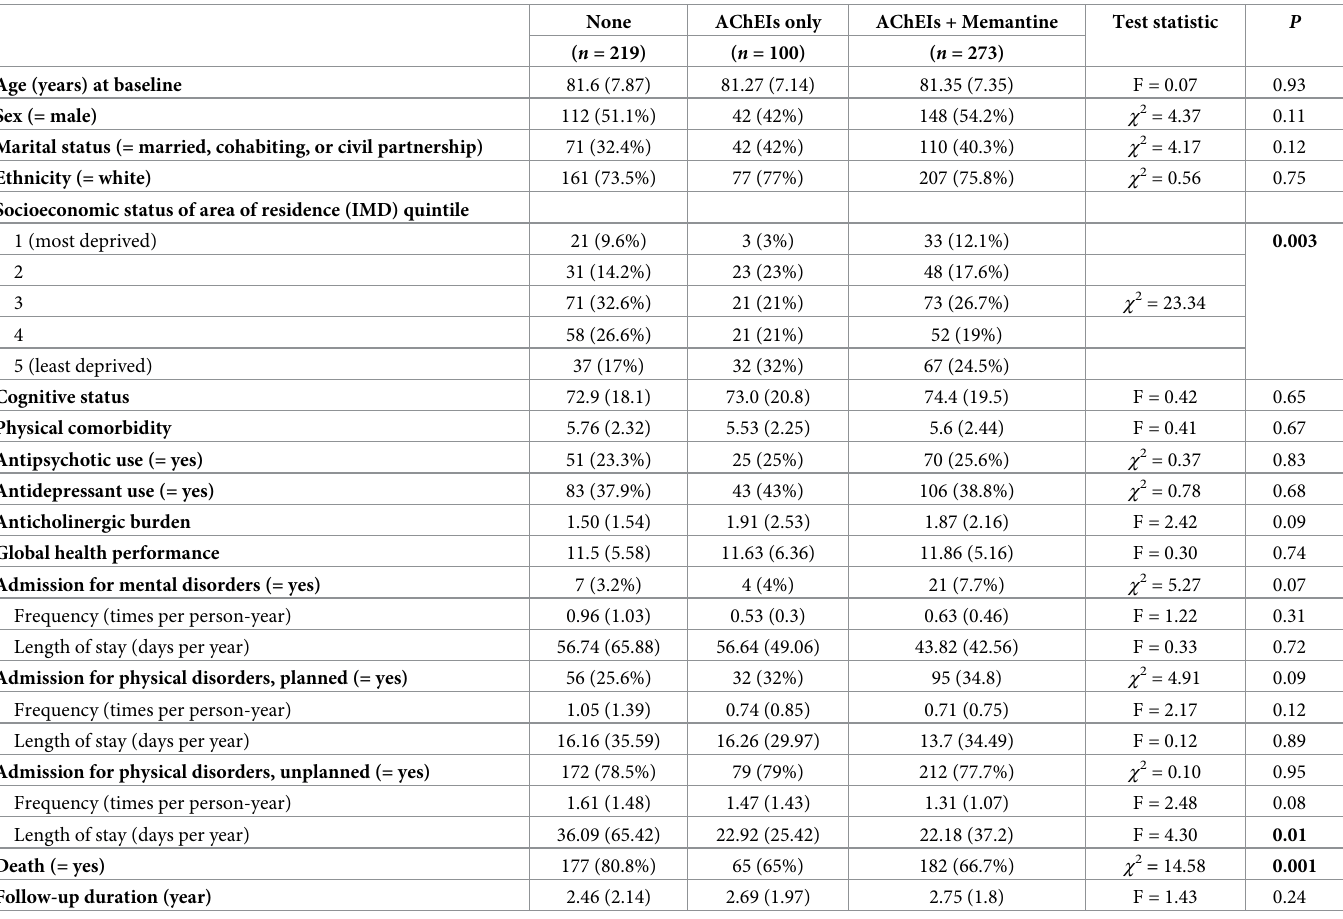
Table 1. AU : AbbreviationlisthasbeencompiledforthoseusedinTable 1 : Pleaseverifythatallentriesarecorrect : Patient characteristics at